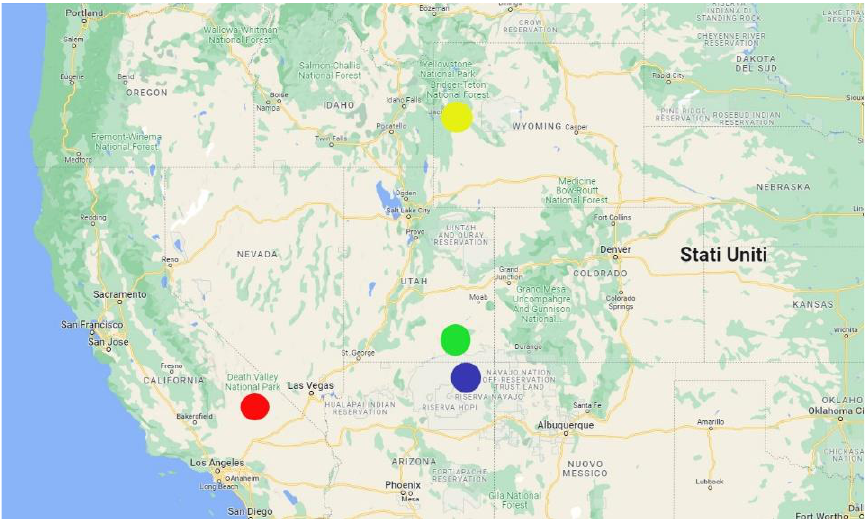
Figure 9. Death Valley (red circle), Monument valley (blue circle), Canyonland (circle green), and Yellowstone (yellow circle) (from Google Map, 39°31′05.38″N, 101°40′06.06″W INEGI 2022, [47], modified) .